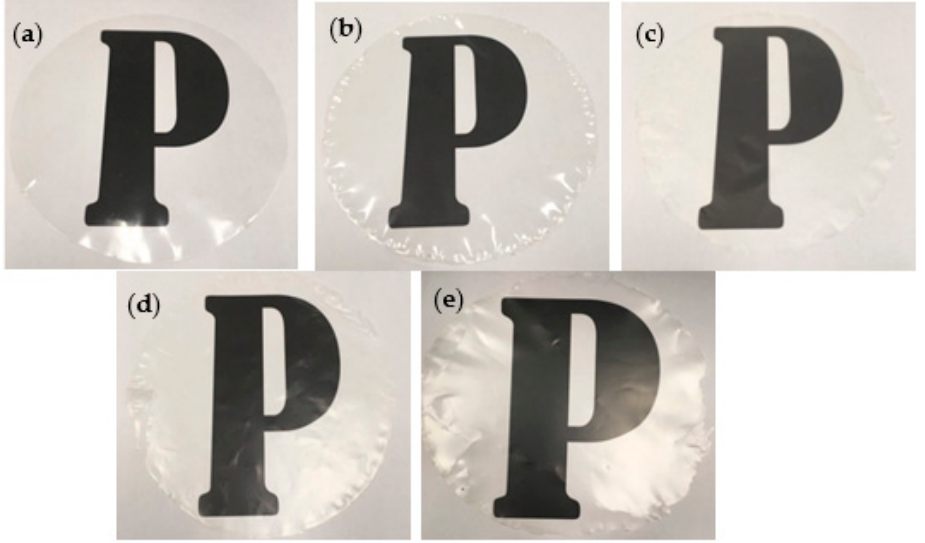
Figure 3. Appearance of the films on alphabet of “P”; ( a ) neat CS film; ( b ) CS/CNP; ( c ) CS/CNP/Thy 1.5%; ( d ) CS/CNP/Thy 3%; ( e ) CS/CNP/Thy 4.5% bio-nanocomposite films.